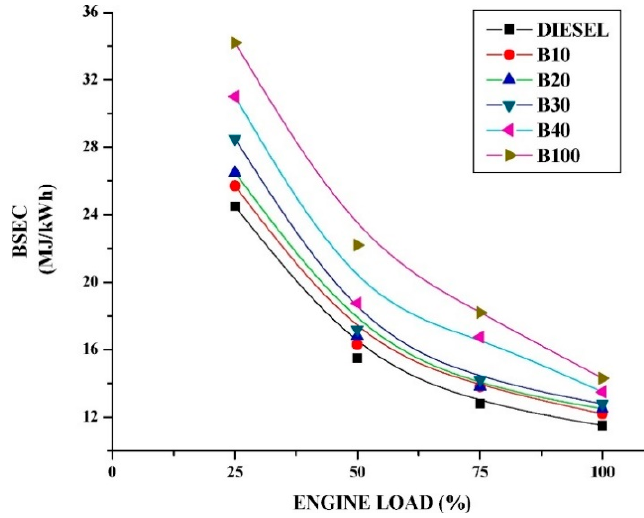
Figure 2. Variation of brake specific energy consumption (BSEC) with different engine loads for different test fuels [30].